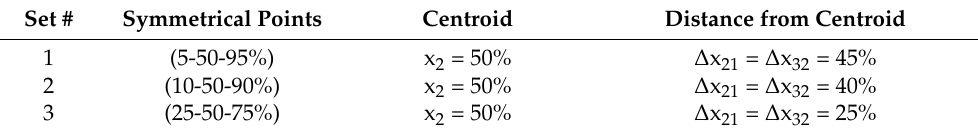
Table 2. Sets of symmetrical points that have been